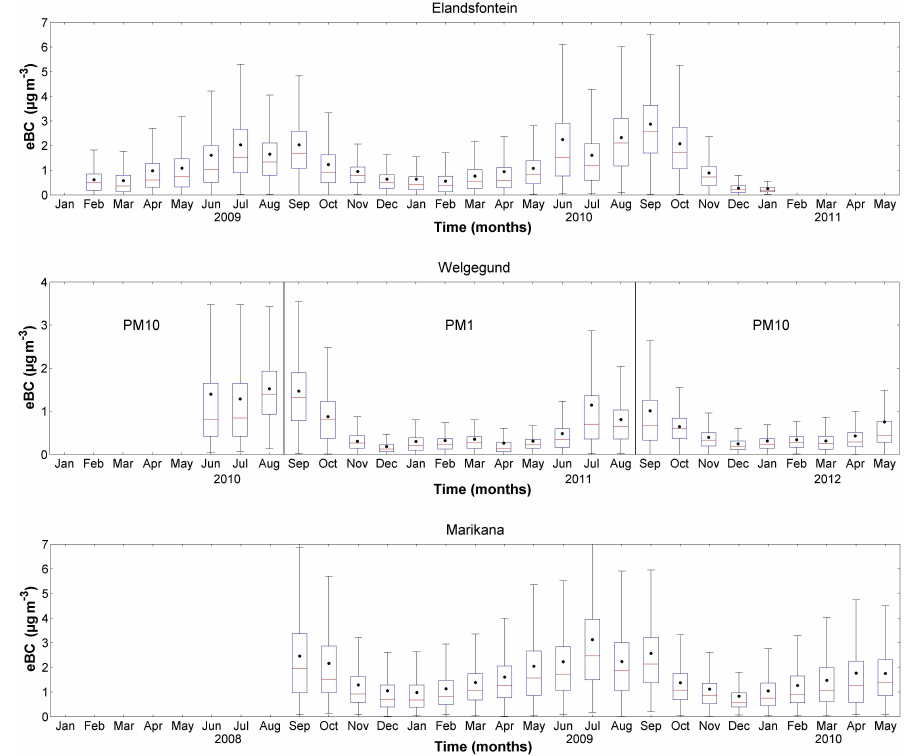
Figure 5. Monthly statistical distribution of eBC concentrations at the three sites where continuous measurement data were gathered, i.e. Elandsfontein, Welgegund and Marikana. PM 10 inlets were used at Elandsfontein and Marikana, while measurements at Welgegund were conducted with either a PM 1 or PM 10 inlet. The red line of each box is the median, the black dots indicate the mean, the top and bottom edges of the box are the 25th and 75th percentiles and the whiskers ± 2.7 σ (99.3% coverage if the data have a normal